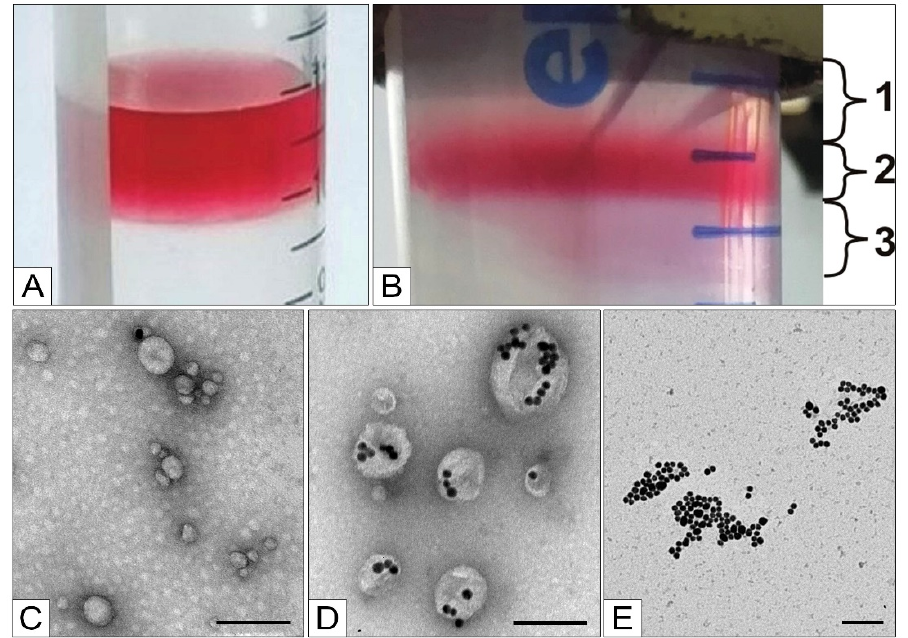
Figure 10. Top row: purification of optimized MLNCs via centrifugation in 75% glycerin. ( A ) The sample is applied to a glycerin layer; ( B ) separation of the sample into three fractions after centrifugation (1: upper fraction, 2: middle (target) fraction, and 3: bottom fraction). Bottom row: fractions of optimized MLNCs obtained via centrifugation in 75% glycerol and purified via dialysis: ( C ) upper fraction, ( D ) middle fraction, and ( E ) bottom fraction. The scale bars correspond to 100 nm. Contrasting by means of a 0.5% uranyl acetate solution followed by TEM.